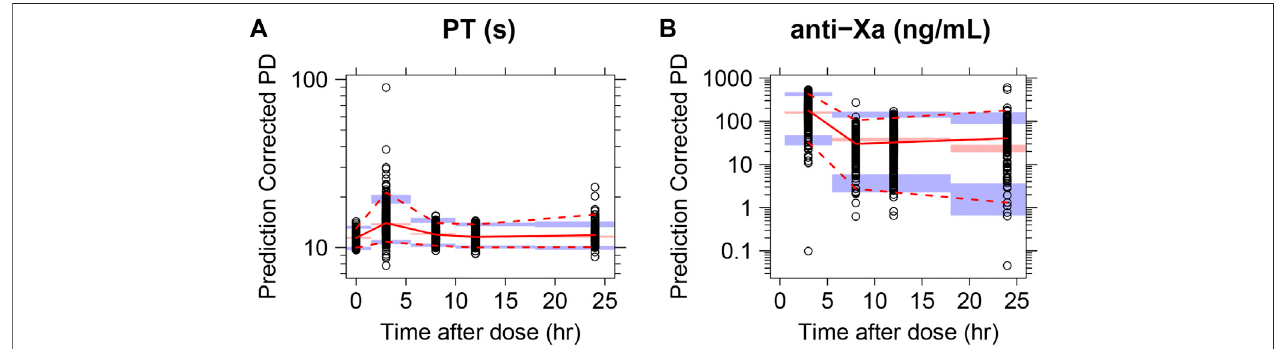
FIGURE 2 | pc-VPC of the integrated PK/PD model. A : PT; B : anti-Xa.